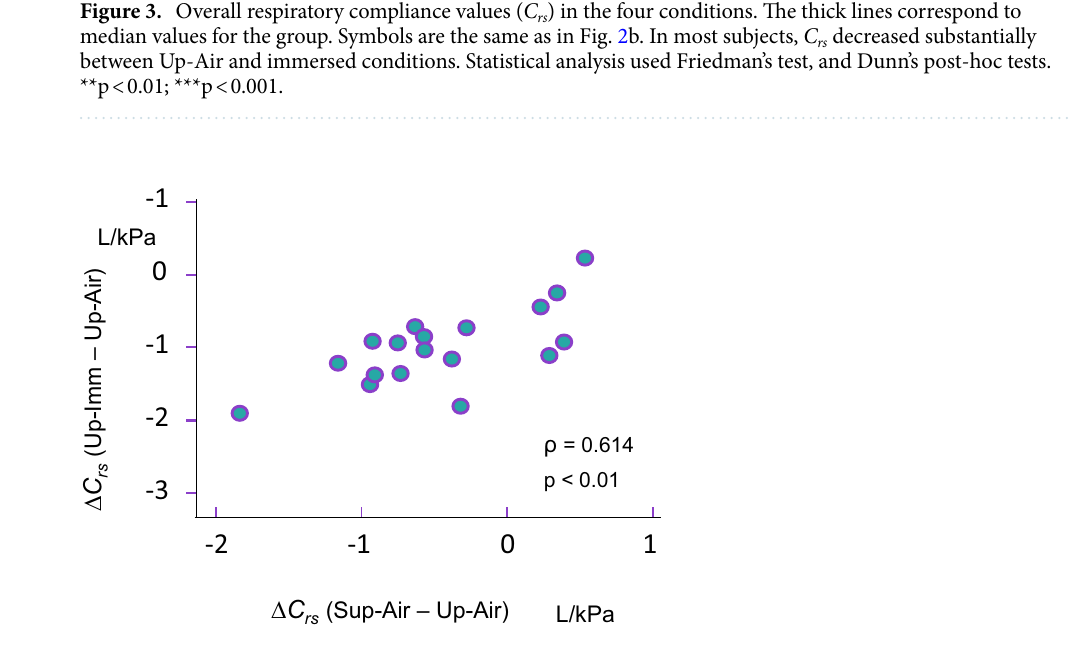
Figure 4. Upright respiratory compliance decreases upon immersion, and the decrease correlates with that measured in air when subjects shifted from an upright to a supine position. Spearman’s rank